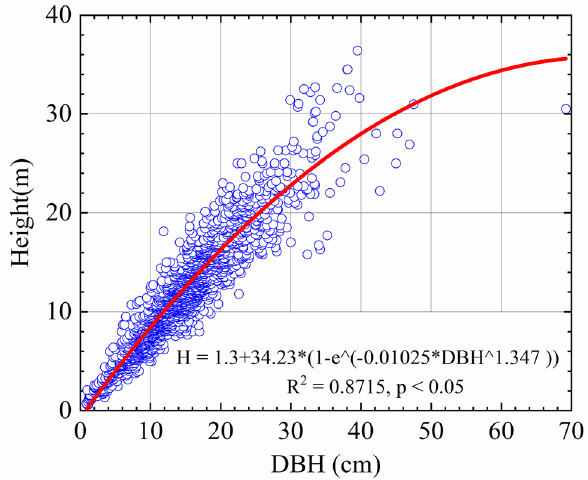
Figure 2. Relationship between diameter at breast height (DBH) and mean tree height (H) in the data set, 0.01025 ∗ DBH 1.347 ) ) Height = 1.3 + 34.23 ∗ ( 1 − e ( − (R 2 = 0.8715, p < 0.05).